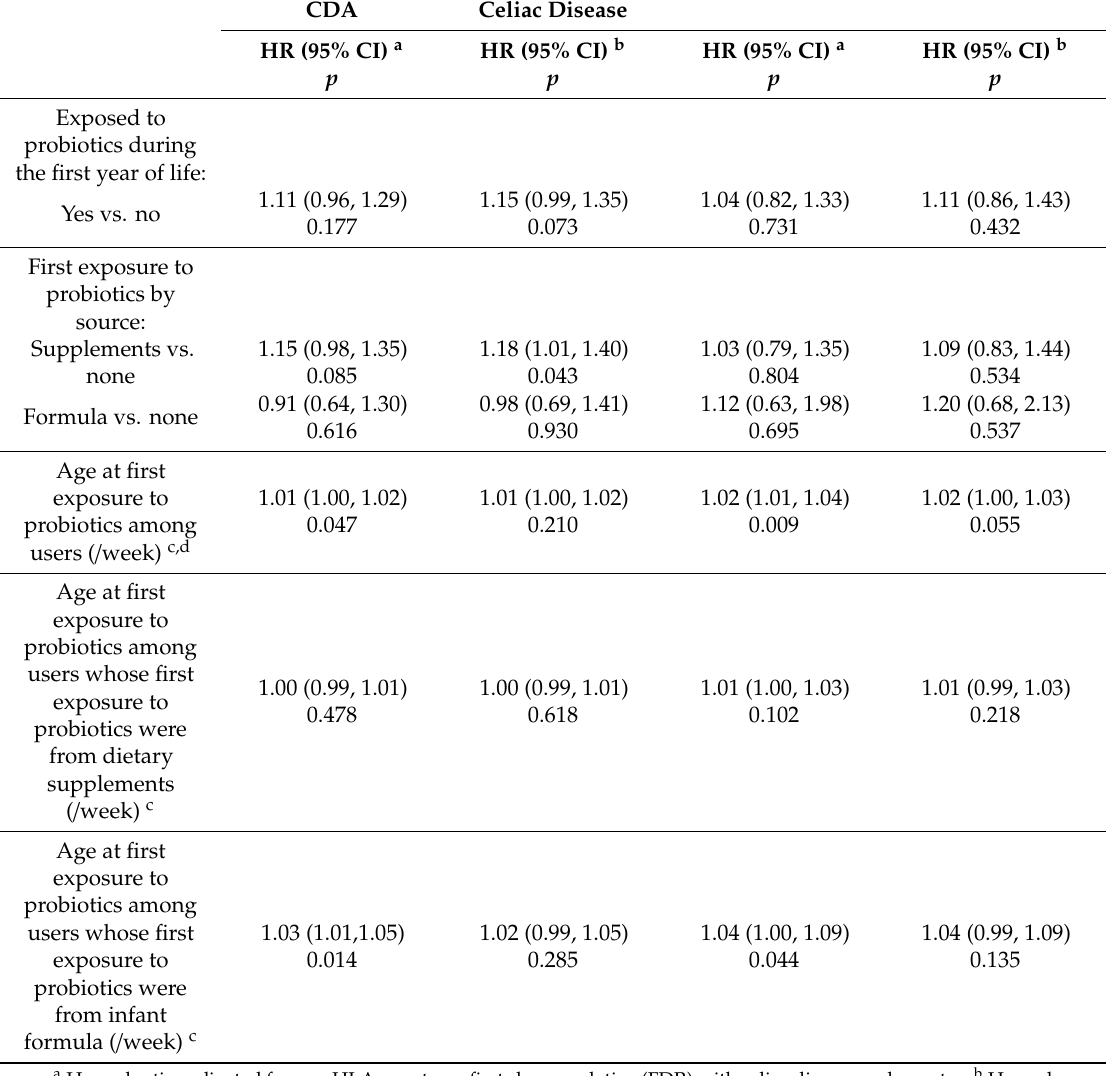
Table 3. Overall probiotic exposure, timing of first probiotic exposure by source, and the risk of celiac disease auto-immunity (CDA) and celiac